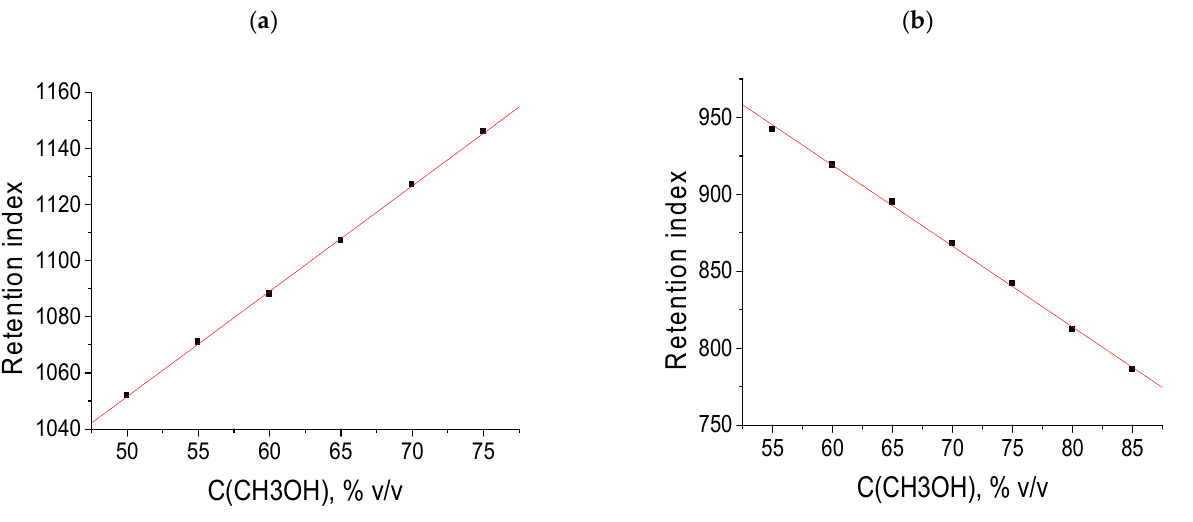
Figure 5. Two examples of the dependencies of the retention indices in RP HPLC on the concentration of methanol in an eluent: ( a ) toluene and ( b ) N-phenyl- p -toluenesulfonamide.